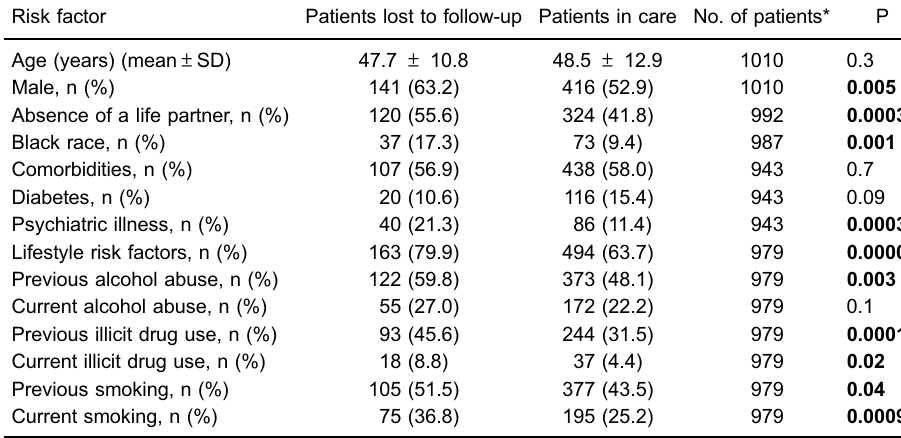
Table 2. Risk factors for loss to follow-up in univariate analysis.